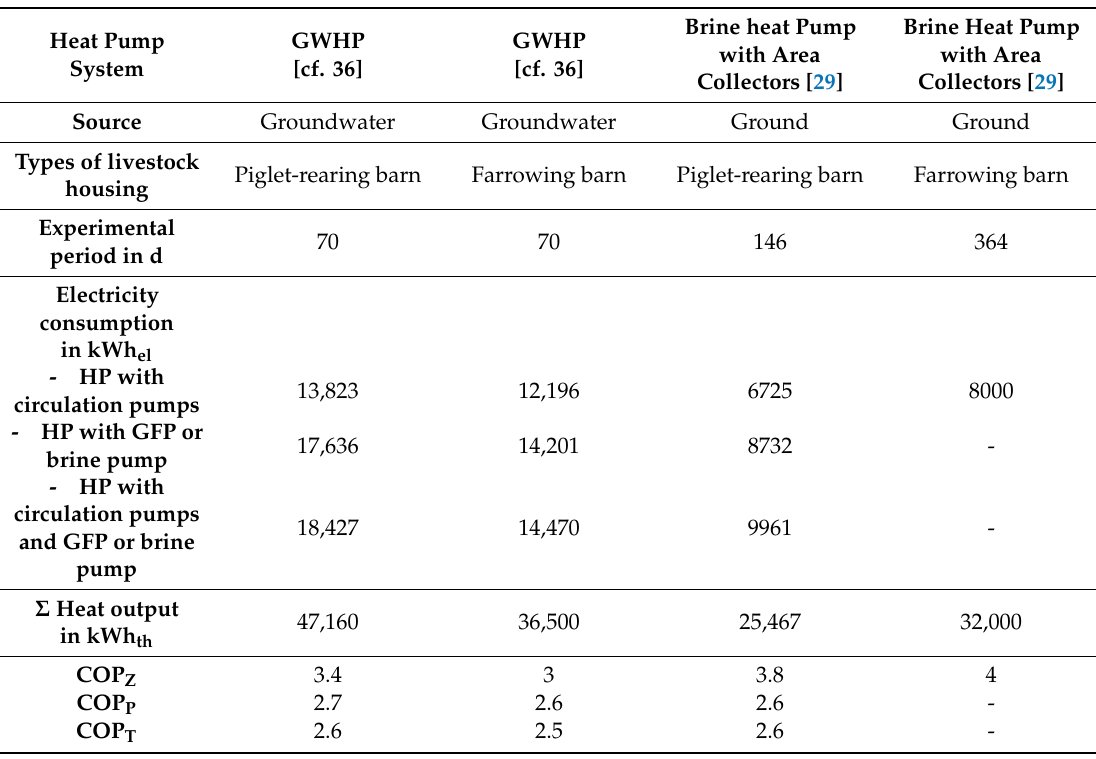
Table 1. Comparison of two heat pump systems of two